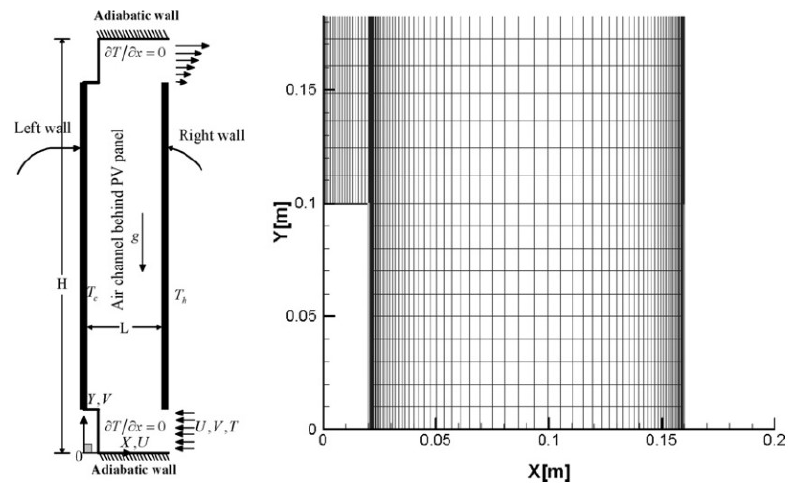
Figure 4. Two-dimensional model for a ventilated double-sided PV façade [85].